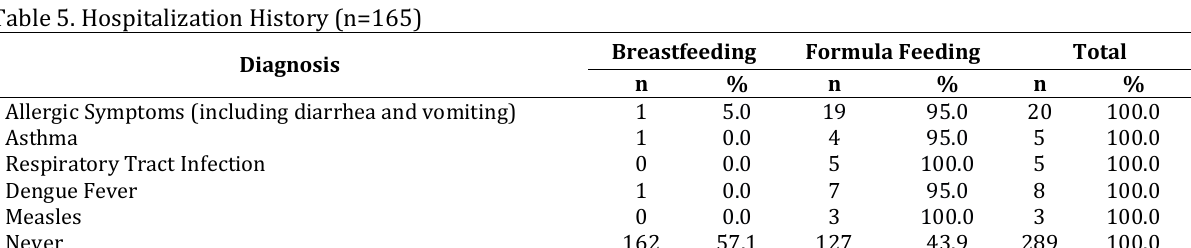
Table 5. Hospitalization History